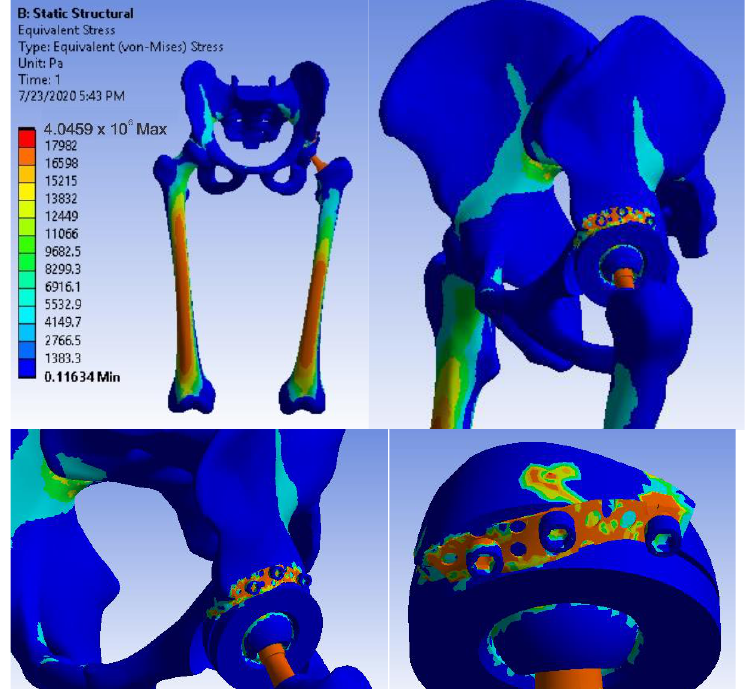
Figure 48. Stress maps for the system with morcellated bone graft.